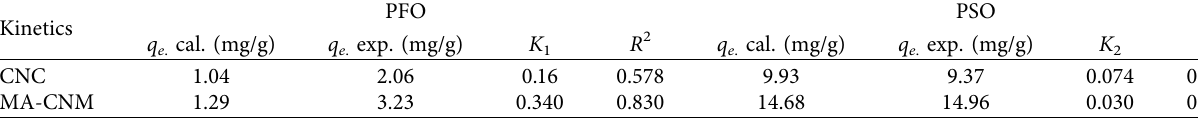
Table 3: The values of parameters and correlation coefficients of pseudo-second-order (PFO) and pseudo-second-order (PSO) kinetics. PFO PSO Kinetics